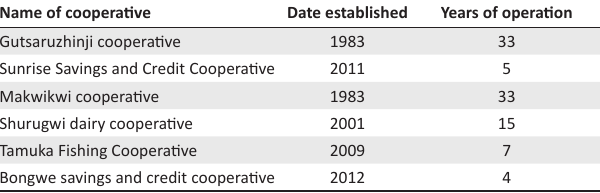
TABLE 1: Main cooperatives in Shurugwi District and their years of establishment. Name of